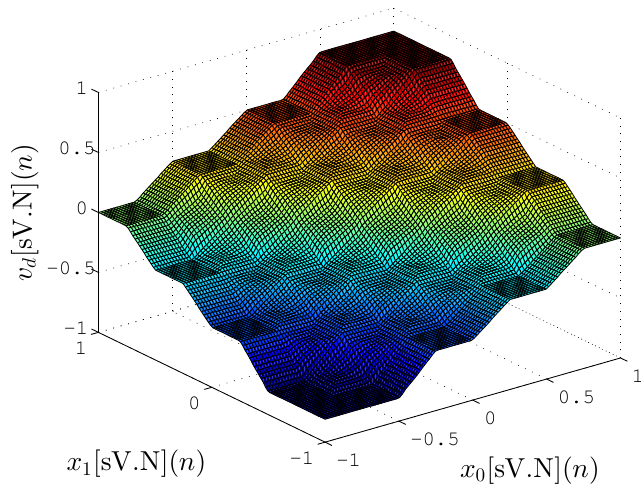
Figure 18. Mapping between input and output from TS-FIMM hardware using fixed-point with N = 8, V = 9 and T =